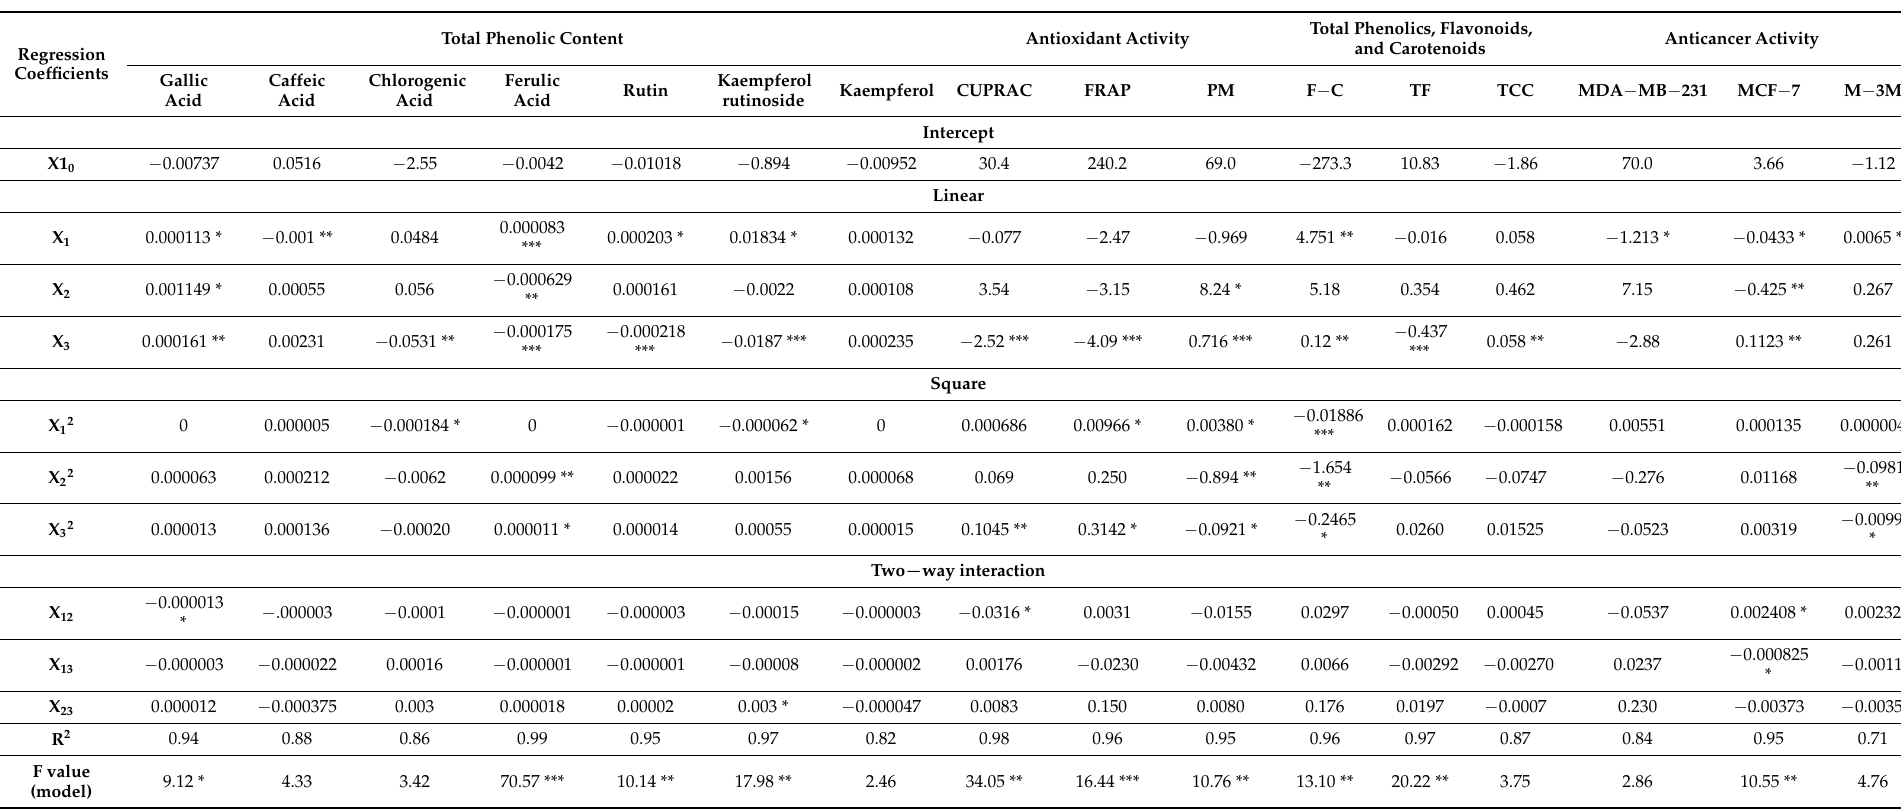
Table 3. The two-way ANOVA summarising the regression models and regression coefficients obtained for antioxidant activity (CUPRAC: cupric reducing antioxidant capacity (mg Trolox/g DW), FRAP: ferric reducing antioxidant power (mg TE/g DW), PM: phosphomolybdenum total antioxidant capacity (mg TE/g DW)); total phenolics, flavonoids, and carotenoids (F-C: Folin–Ciocalteu reductive capacity (mg GAE/g DW), TF: total flavonoid content (mg QEs/g DW), TCC: the total carotenoid content (mg ( β -carotene)/g)); and anticancer activity (MDA-MB-231: human breast cancer cell line, MCF-7: breast cancer cell line, M-3M: skin cancer cell line) of spray-dried tamarillo